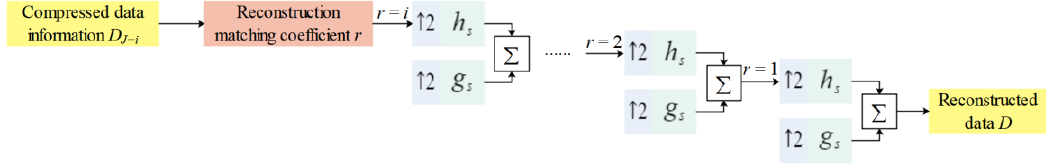
Figure 6. Flow chart of self-matching wavelet reconstruction.